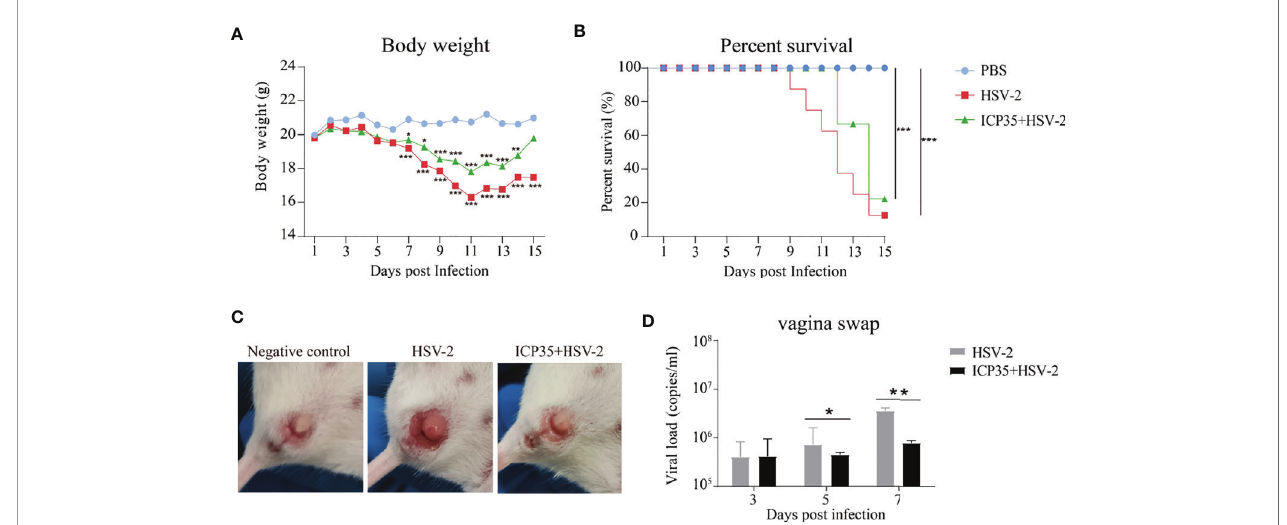
FIGURE 4 | Immunization with ICP35 attenuated the clinical symptoms in mice challenged with HSV2. (A) The mice were monitored daily after challenge to observe their symptoms (n=10/group). Decreased body weight was observed in the immunized with ICP35 (ICP35+HSV-2), with Al (OH) 3 adjuvant groups (HSV-2) and PBS negative control groups (PBS), but beginning on day 7, this trend differed between the experimental and control groups. The data are the mean of ten independent animals. *P<0.05, **P<0.01, ***P<0.001 vs. PBS. (B) The survival rate of mice challenged with HSV2 was monitored daily (n=10/group). Death occurred in the Al (OH) 3 adjuvant groups (HSV-2) beginning on day 9, and death occurred in the ICP35 immunized group (ICP35+HSV-2) beginning on day 11. ***P<0.001. (C) The clinical symptoms of the mice challenged with HSV2 in the immunized with ICP35 (ICP35+HSV-2) and with Al (OH) 3 adjuvant groups (HSV-2). PBS group without challenge as negative control. (D) The detection of the viral load by vaginal swab in the immunized with ICP35 (ICP35+HSV-2) and with Al (OH) 3 adjuvant groups (HSV-2) after viral challenge. The data are the mean ± SD of three independent animals.